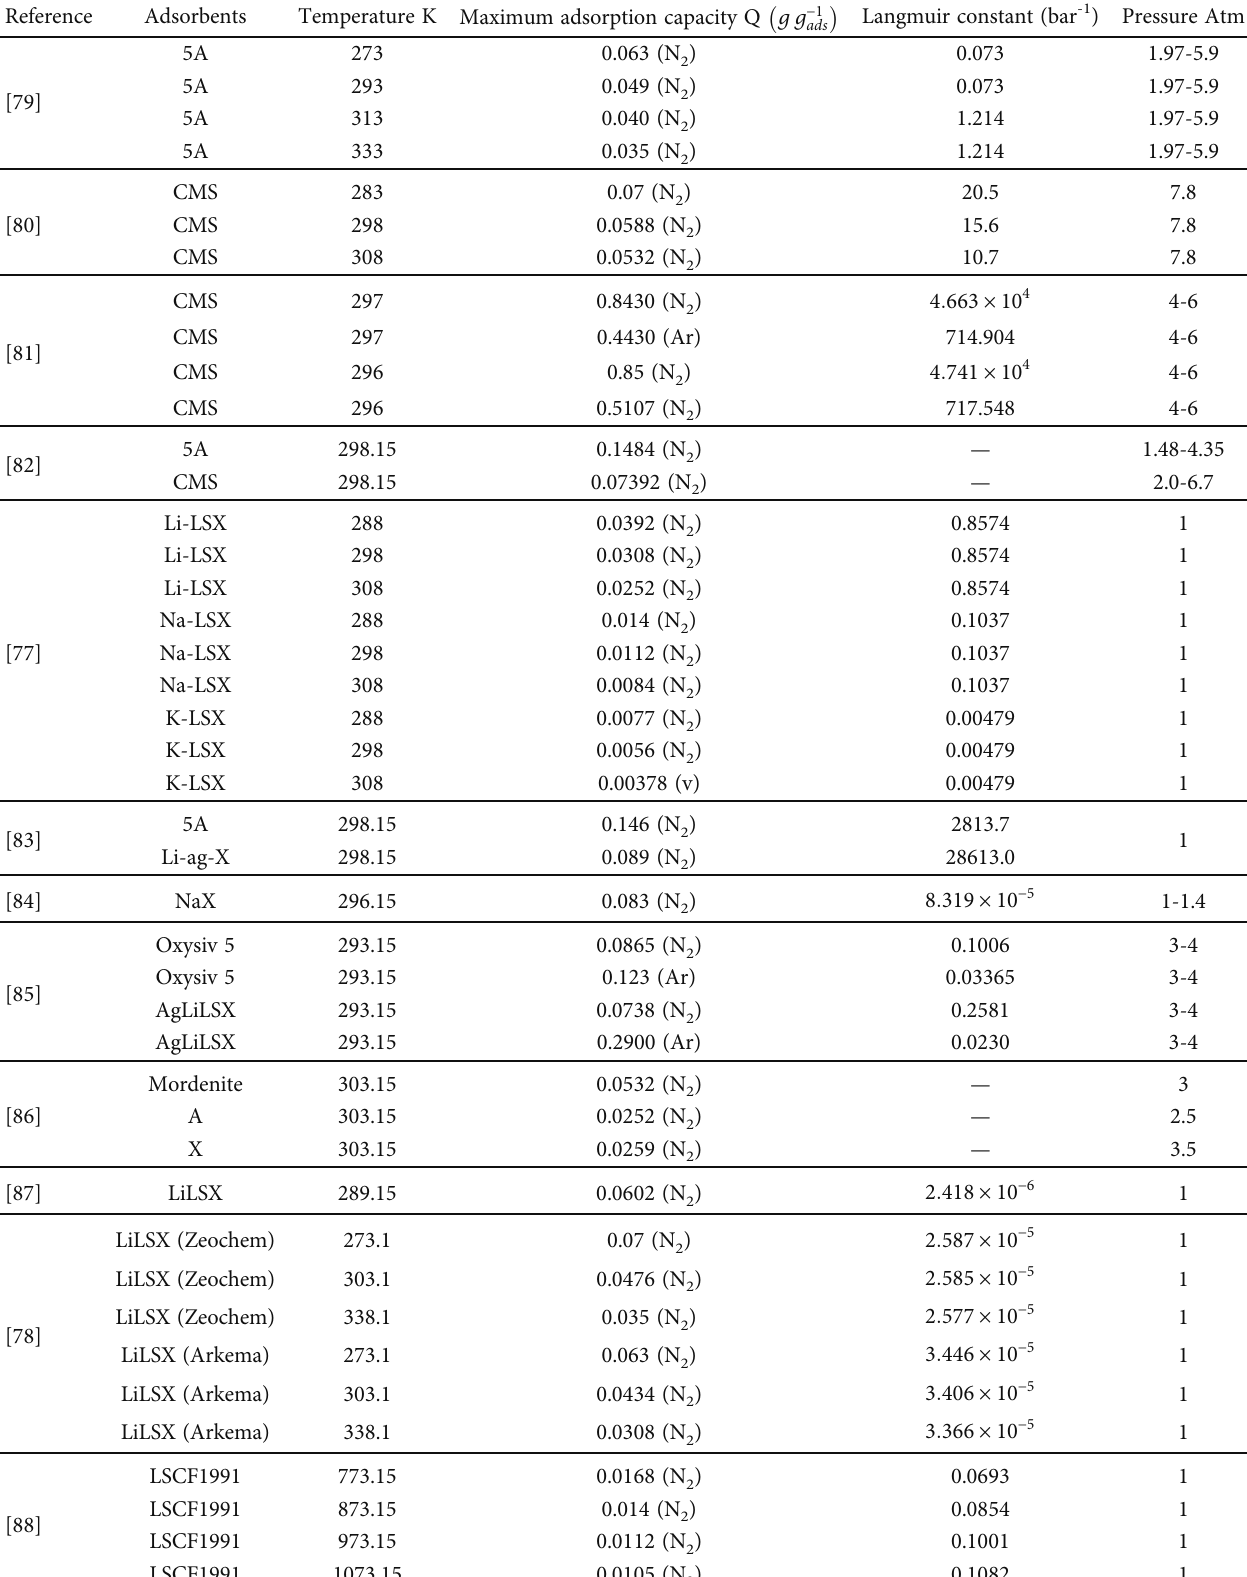
Table 14: Comparison of the thermodynamic values of various adsorbents as a function of di ff erent temperatures and pressures.